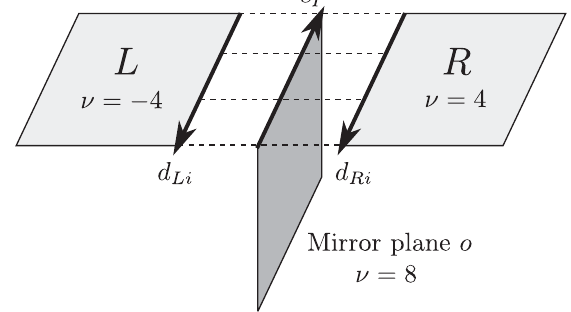
FIG. 7. Construction of the gapped surface for the E 8 root state. A ν ¼ 8 IQH state lies on the mirror plane, while ν ¼ (cid:2) 4 IQH states lie on the surface in regions R and L , respectively. Each of these three regions is a half plane, with edges supporting chiral modes indicated by the dark lines. The 1D fermion fields are c I , d d Ri , Li , with chiralities as indicated. The same which resides on the “ T-shaped ” lattice formed by the union of the three regions, and connects the regions as indicated by the dashed lines, is coupled to the fermion